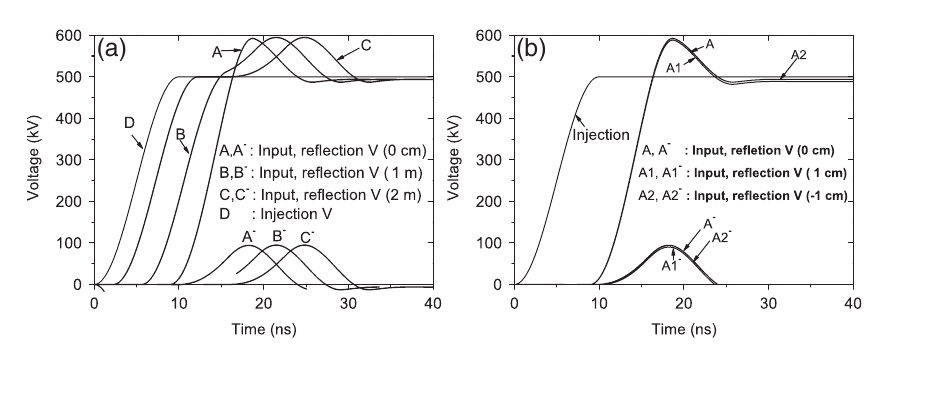
FIG. 4. The amplitude of the output voltage versus time (a) at interface A, B, and C and (b) at A, A1, A2 in Fig. 3(c); superscript, ‘‘ (cid:3) ’’: reflected voltage.